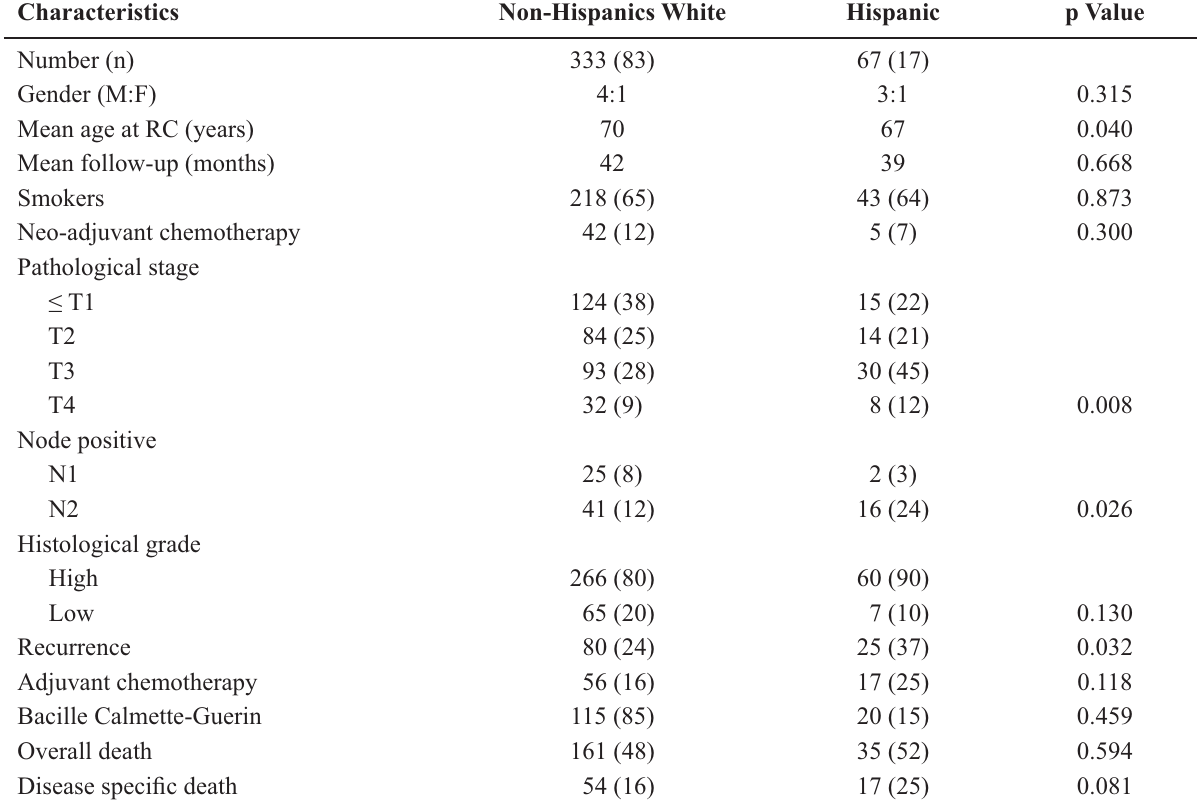
Table 1 – Descriptive details for the Hispanic and non-Hispanic white patients.